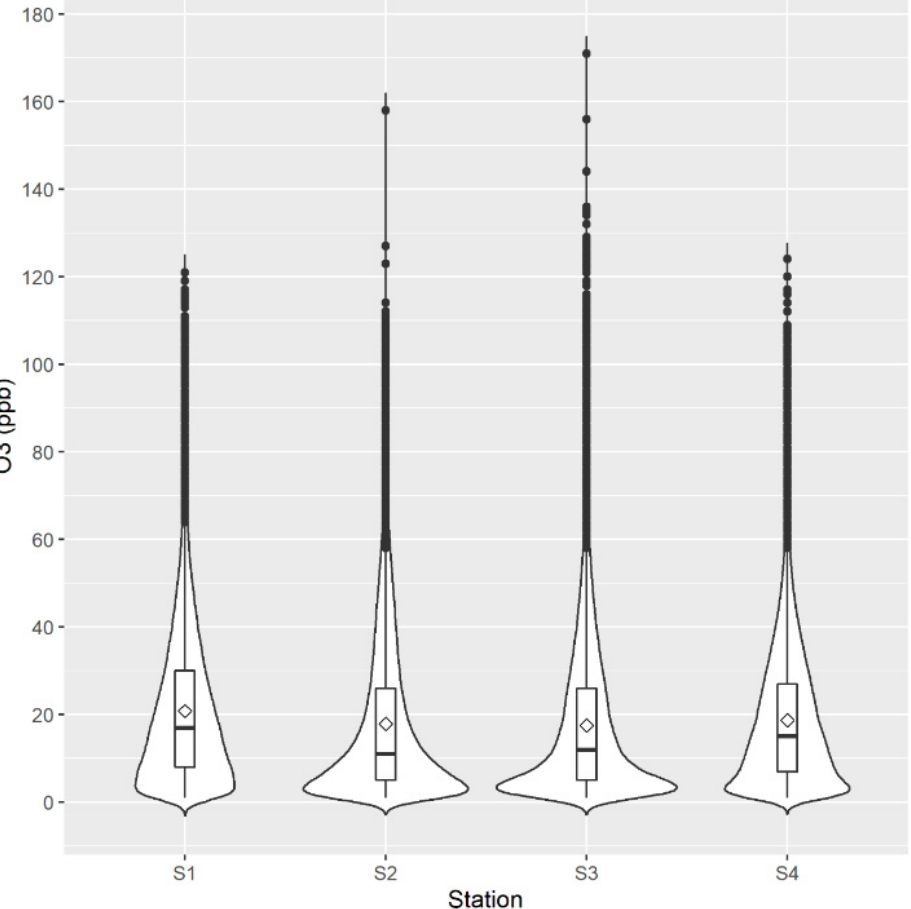
Figure 2. The violin plot provides a mirror image of the probability density function for each station. Box plots are also shown and mean values are labeled with diamond shaped markers.